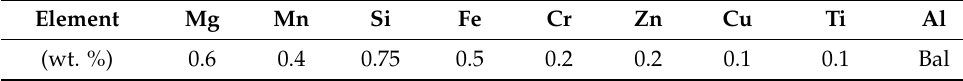
Table 1. The chemical composition of aluminum alloy AA6082-T6.